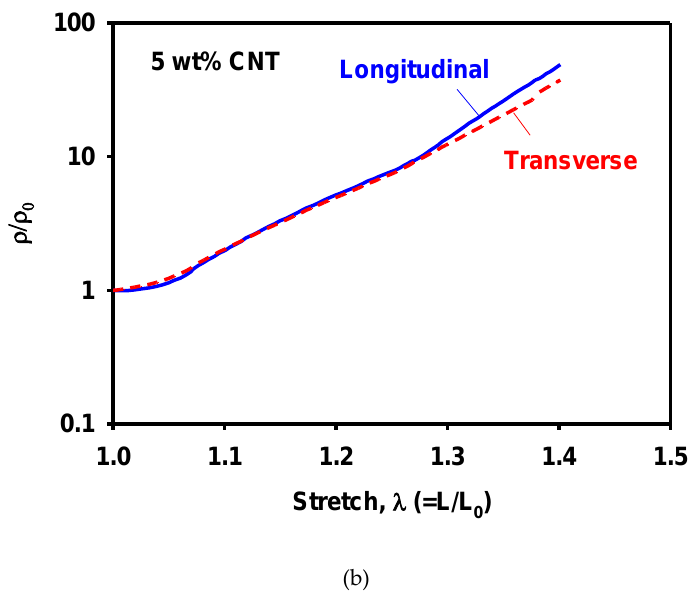
Figure 9. Measured variation of ( a ) normalized resistance and ( b ) normalized resistivity with respect to stretch during uniaxial tension.